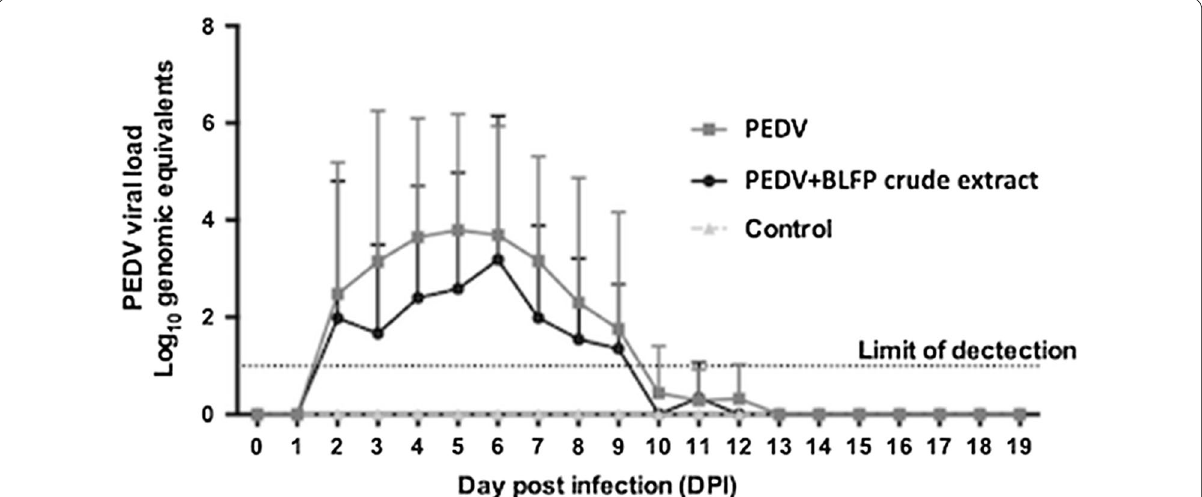
Fig. 3 Fecal shedding of PEDVPT‑P6 detected in piglets fed < 5 kg/ton BLFP in each group (n group was similar to but lower than that of the PEDV group during the study, with no significant difference detected. Changes in the mean values of genomic equivalents (GE)/mL are presented as log10 values compared using a non‑parametrical Kruskal–Wallis test